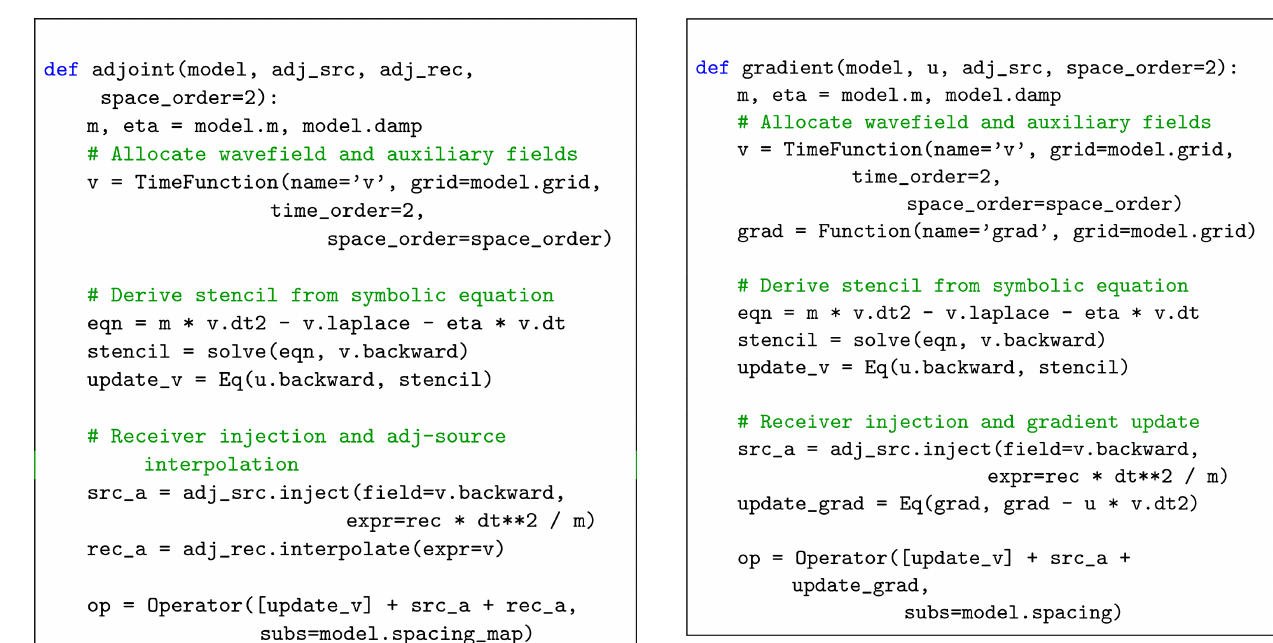
Figure 5. Example definition of an adjoint operator.